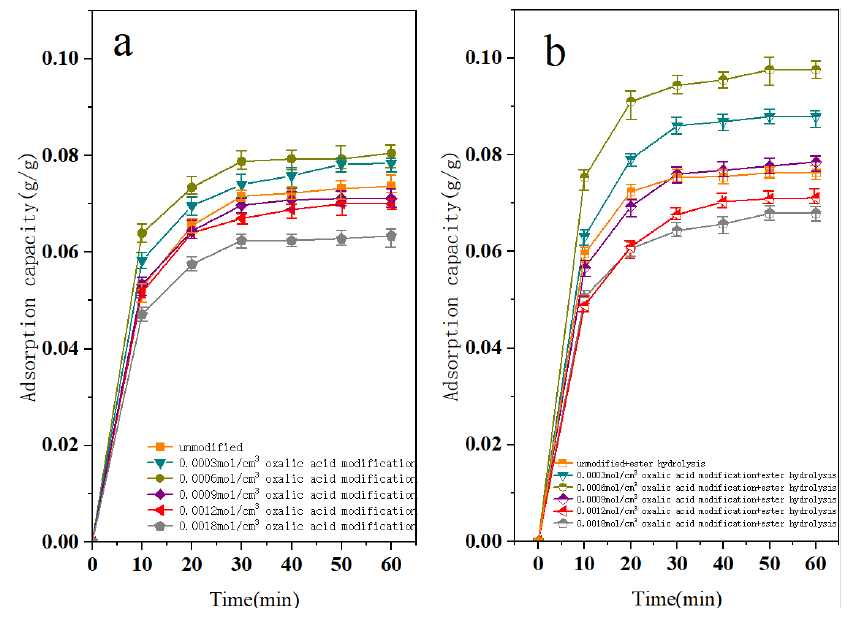
Figure 7. Static adsorption curves of activated carbon under the same temperature and humidity (30 °C, 80%) and different modification methods. ( a ) Water vapor static adsorption curve of different concentrations oxalic acid modified activated carbon at the same temperature and humidity. ( b ) Water vapor static adsorption curve of different concentrations oxalic acid + ester hydrolysis modi- fied activated carbon at the same temperature and humidity.